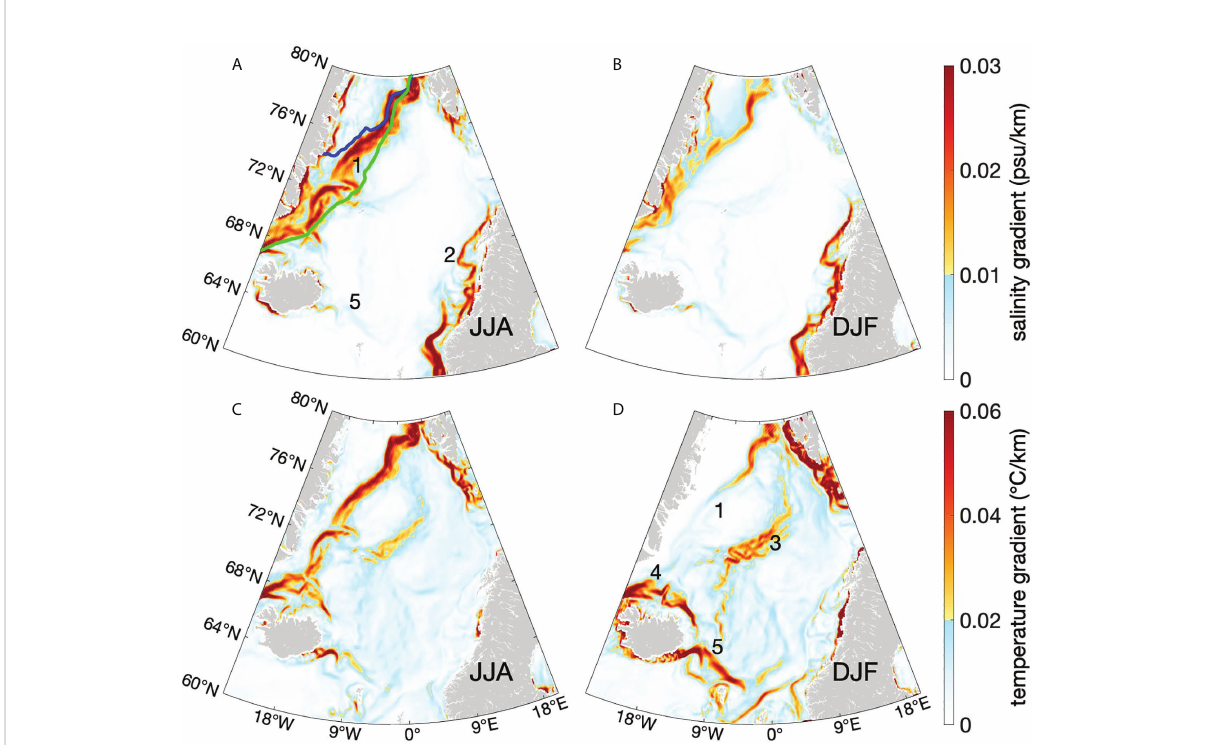
FIGURE 2 Spatial distributions of the horizontal gradient of (A) June to August (JJA) climatological average sea surface salinity, (B) December to February (DJF) climatological average sea surface salinity, (C) JJA climatological average sea surface temperature, and (D) DJF climatological average sea surface temperature. Numbers 1 to 5 in the fi gure represent the positions of (1) the East Greenland Polar Front, (2) the Norwegian Shelf Front, (3) the Arctic Front, (4) the Iceland Coastal Front, and (5) the Iceland – Faeroe Front. The green line is the median ice edge in February, and the blue line is the median ice edge in August (15% sea ice